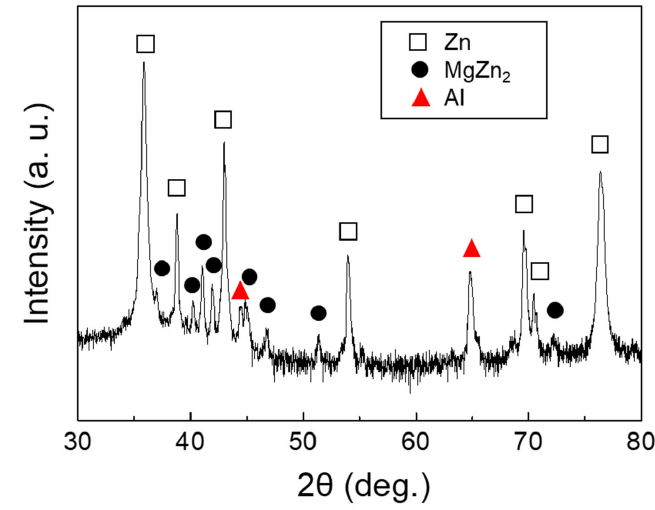
Figure 5. XRD of the SF30 sample with the Zn, MgZn 2 , and Al phases.